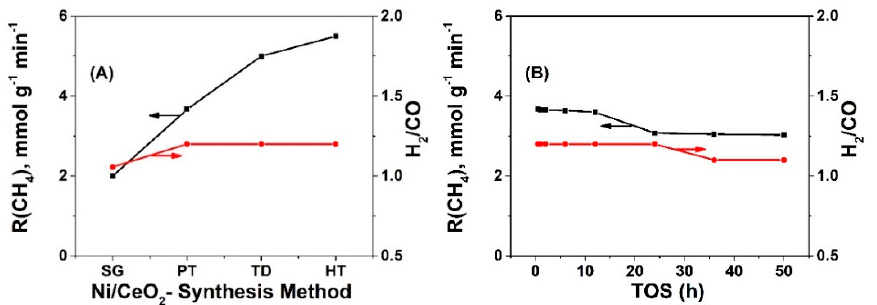
Figure 2. ( A ) Specific integral rates of CH 4 conversion (mmol g cat − 1 min − 1 ) and H 2 / CO gas product ratio obtained after 30 min of DRM at 750 ◦ C (GHSV ~30,000 h − 1 ) over the four catalysts; ( B ) Stability test in terms of integral rate of CH 4 conversion conducted over 50 h of TOS on 5 wt% Ni / CeO 2 -PT catalyst; GHSV ~30,000 h − 1